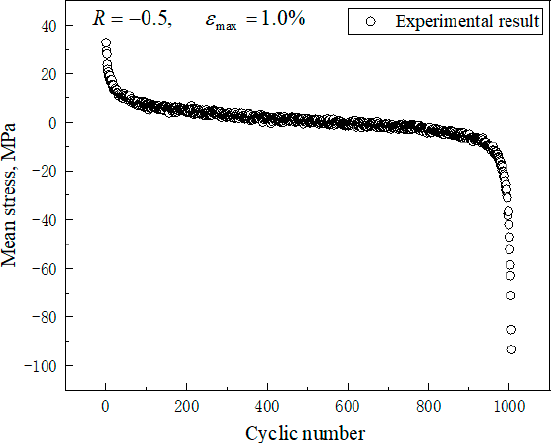
Figure 6. Results of mean stress relaxation characteristic test of GH4169 alloy.